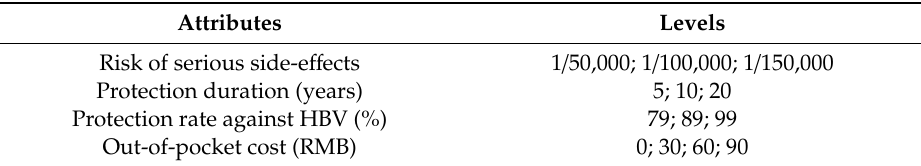
Table 1. Attributes and